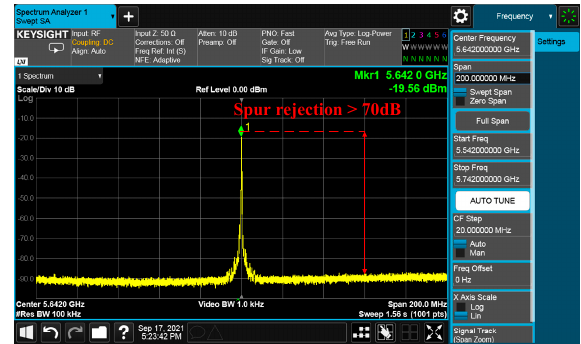
Figure 13. Measured spur of the PLL at 5.642 GHz.